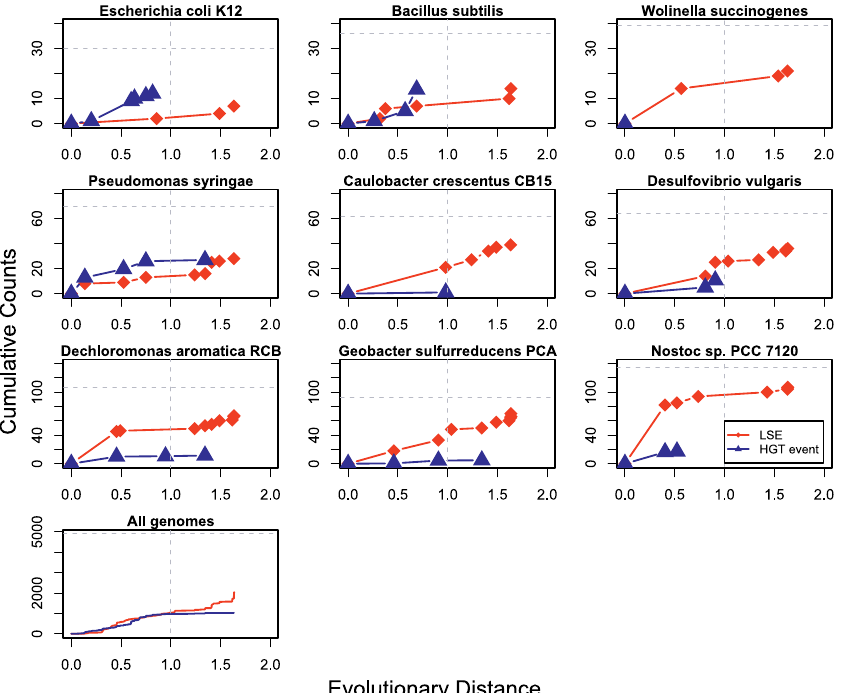
Figure 11. HPK Evolution over Time The number of HPKs entering a lineage is shown as a function of the time each HPK entered that lineage (i.e., the distance of that species to the last ancestor predicted to contain that HPK). Red lines/diamonds indicate LSE events, and blue lines/triangles indicate HGT events. Plots are cumulative showing all events dating more recently than the distance shown on the x -axis. HGT lines do not extend as far to the right as LSE lines, since they require genes to be lost from two consecutive outgroups. The vertical dashed line shows the phylogenetic cutoff distance, and the horizontal dashed line shows the total number of HPKs in each genome. Symbols indicate the evolutionary distance (arbitrary units; see Methods) of outgroups used in the analysis. Some clades with greater taxon sampling have better resolved timings. The last panel shows total numbers for all genomes.